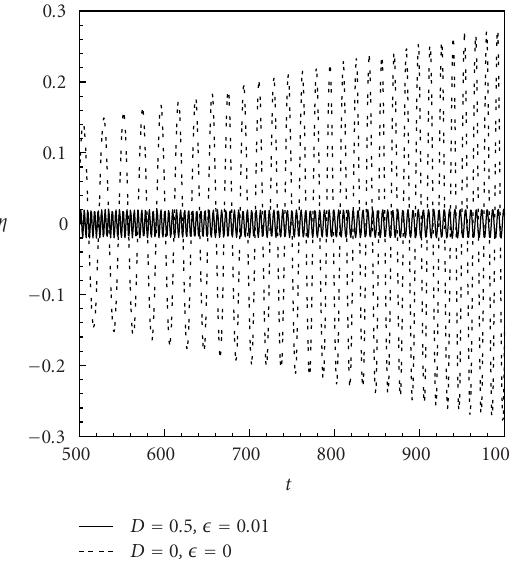
Figure 5.2. Wave motion due to initial displacement for fixed distance x = 1000; (cid:1) = 0 . 01, D = 0 .